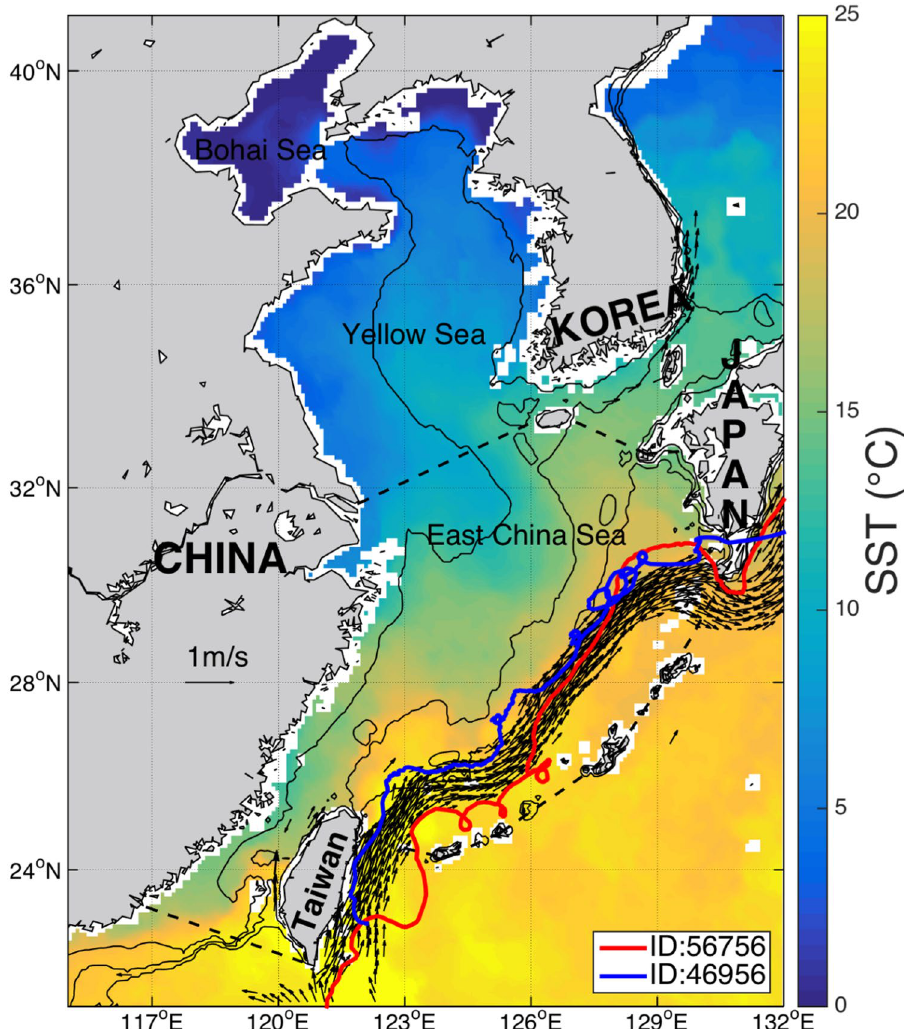
Figure 1. The study area: East China Sea area with boundaries marked out by the dashed line. The northwest boundary is from Qidong to Jeju Island. The northeast boundary is from Jeju Island to Fukue-jima to Nagasaki. The south boundary is from Nan’ao Island to the southernmost of the Taiwan Island. The east boundary is from Kyushu and along the Ryukyu Islands (Osumi Shoto, Amami Islands, Okinawa Shoto) to Taiwan Island. Examples of cyclonic and anticyclonic eddies along the climatological Kuroshio Current (the black arrows, > 50 cm/s) averaged within 0.2° * 0.2° bin from the 2000–2015 Global Drifter Program (GDP) trajectory data set. Blue line is the trajectory of drifter with ID46956, and red line is the trajectory of drifter with ID56756. The sea surface temperature (SST) front can be clearly seen near the 50, 100 and 200 m isobaths (thin black lines). The SST data is come from the 1 st -Jan-2013 RSS Microwave-IR (MW-IR) Optimal Interpolated SST (version 4.0) data set. Figure is plotted using MATLAB R2014b (http://www.mathworks.com/) with M_Map (a mapping package,